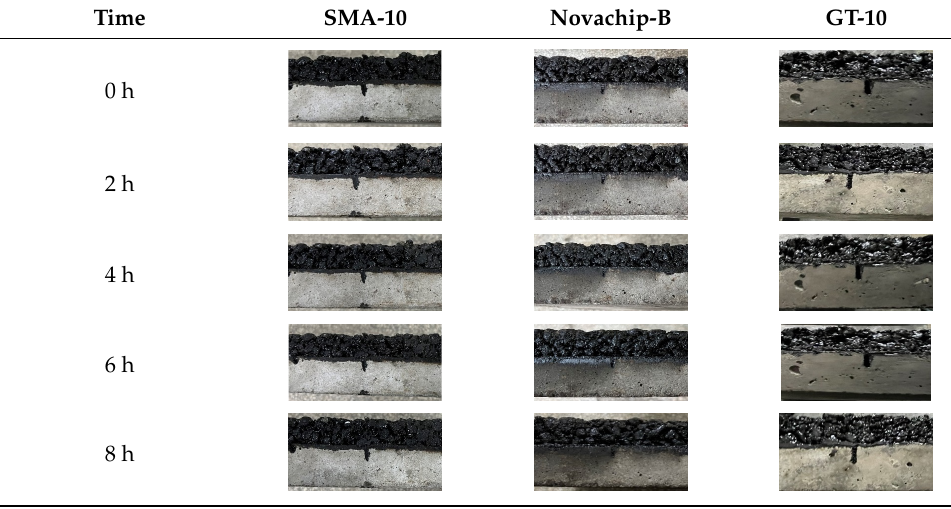
Figure 12. Results of composite specimens with different cracks. 3.7. Anti-Skid Performance and Durability The anti-skid performance test effectively reflects skid resistance attenuation, and it was characterized by the texture depth (TD) and BPN in this study. As shown in Figure 13, as kneading times increased, the BPN and TD of the three UTWCs presented an obvi- ous downturn, and the corresponding anti-skid performance decreased. After the knead- ing experiment at room temperature for 8 h, the TD of SMA-10, Novachip-B, and GT-10 decreased by 18.9, 22.6, and 17.8%, respectively. In contrast, the BPN decreased by 13.7, 12.8, and 4.7%. The TD and BPN of GT-10 were also superior to the other two mixtures in absolute value. However, the TD and BPN of each exhibited different variation patterns. GT-10 decreased with a fast attenuation rate in the early stage, but then it slowed down and stabilized in the later stage. For SMA-10 and Novachip-B, the TD and BPN decreased continuously, and the attenuation rate did not slow down. It can be concluded that the anti-skid performance of GT-10 was superior to that of Novachip-B and SMA-10. Figure 13. Results of the anti-skid performance test. Table 9 shows that, after an 8 h kneading experiment at room temperature, the three mixtures were unchanged with no apparent cracks or rutting, showing that three kinds of asphalt mixtures had good durability at room temperature. Table 9. The situation of composite specimens every 2 h.